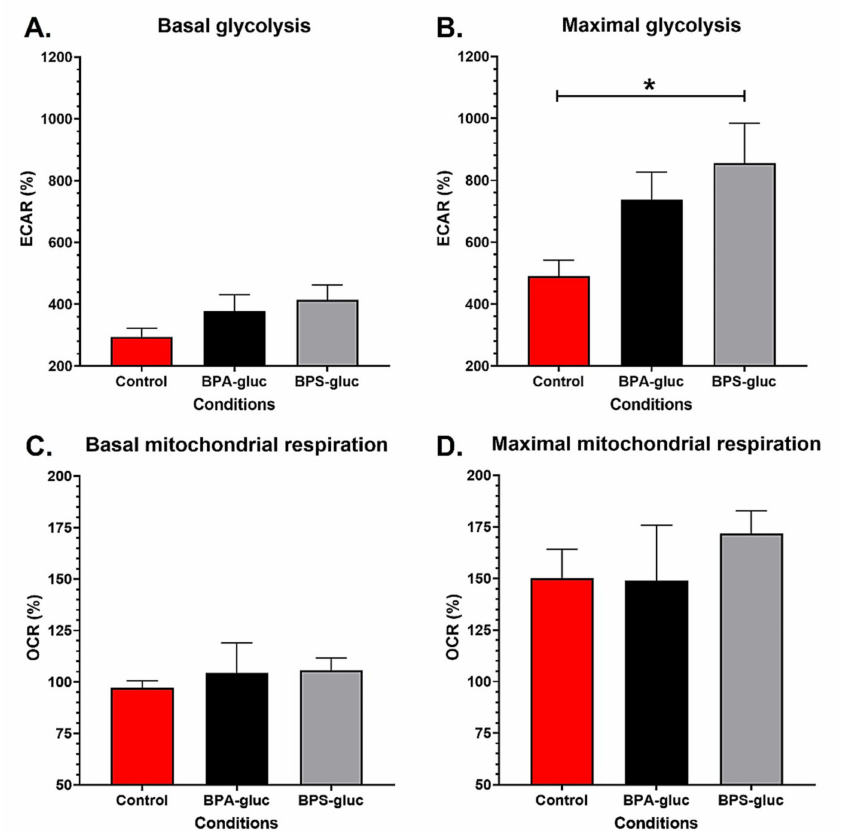
Figure 3. Chronic exposure to physiological concentrations of glucuronidated BPS increases the maximal glycolytic capacity of T24 invasive bladder cancer cells. ( A , B ) ECAR and ( C , D ) OCR were determined using the XFe96 Extracellular Flux Analyzer of T24 invasive bladder cancer cells with or without chronic exposure to physiological concentrations of BPA-gluc or BPS-gluc to establish ( A ) basal glycolytic capacity, ( B ) maximal glycolytic capacity, ( C ) basal mitochondrial respiration and ( D ) maximal mitochondrial capacity. Data are presented as the mean ± SEM and displayed as percentages of controls (i.e., untreated condition) (n ≥ 3, N = 3). The baseline (100%) was established before injections (see Figure S3). * p < 0.05 by Mann–Whitney